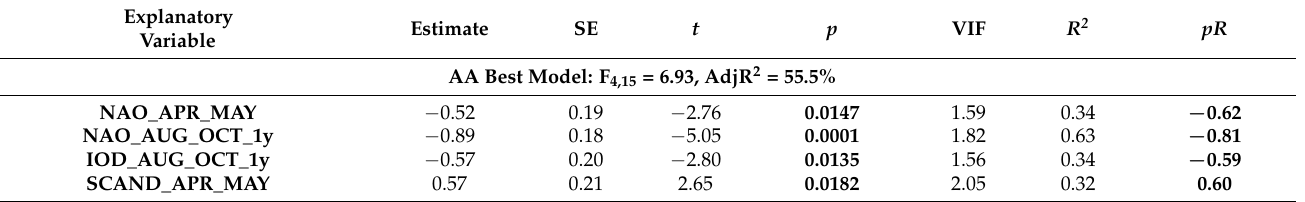
Table A14. Relationships between 15 climate variables and year and Annual Anomaly of the timing of spring migration for the Common Whitethroat Curruca communis caught at Bukowo, Poland, in 1982–2021. Symbols as in Tables 1 and A12. p < 0.05 marked in bold